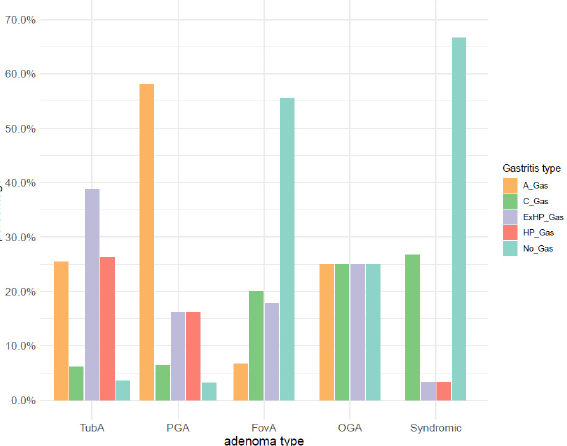
Figure 5. Distribution of the main gastritis groups within adenoma types. TubA: intestinal-type adenoma; PGA: pyloric gland adenoma; FovA: foveolar-type adenoma; OGA: oxyntic gland adenoma; A_Gas: autoimmune gastritis; C_Gas: chemical reactive gastritis; ExHP_Gas: Ex- H. pylori Gastritis; HP_Gas: H. pylori Gastritis; No_Gas: no gastritis.